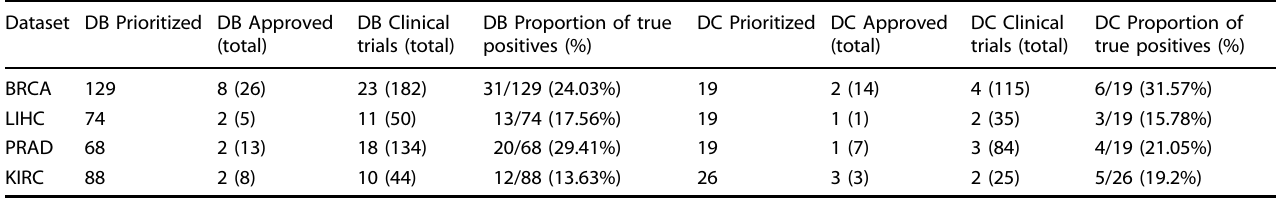
Table 1. Number of FDA-approved and clinically tested drugs recovered for both drug-target datasets (i.e., DrugBank (DB) and DrugCentral (DC)) across the four investigated